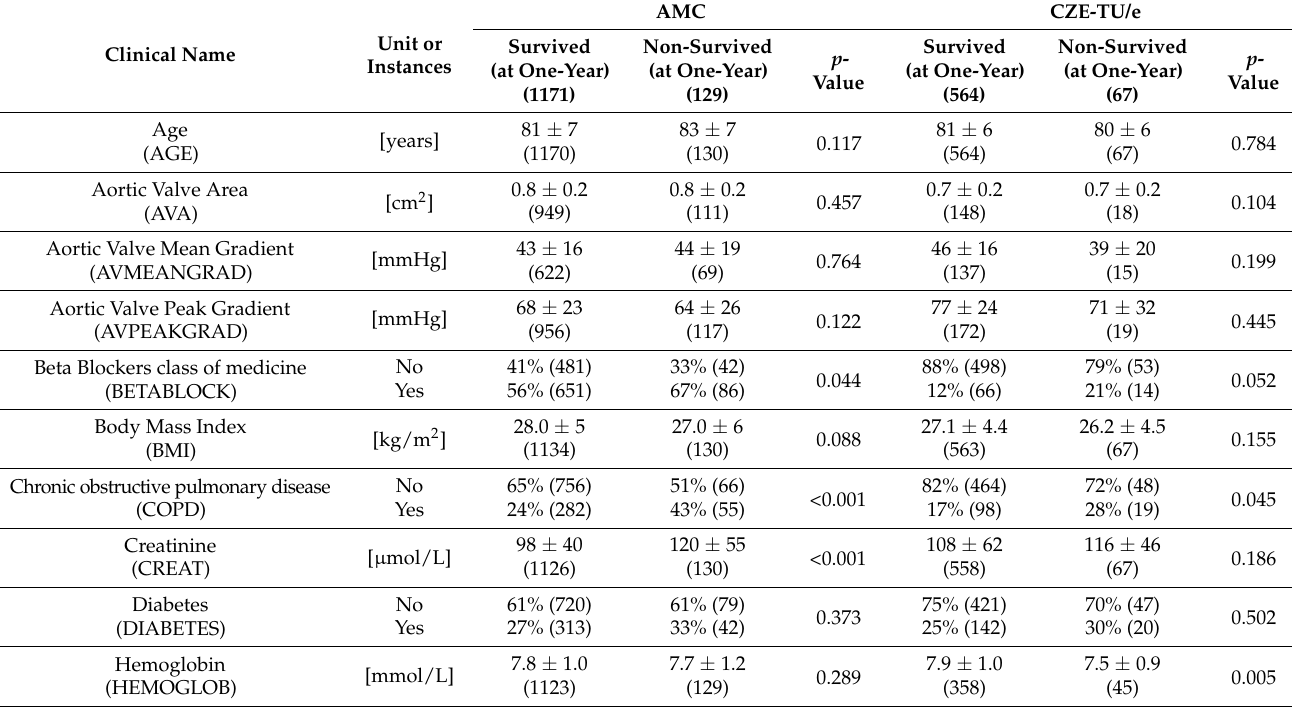
Table A3. Summarized patient characteristics from Amsterdam UMC (AMC) and Catharina hospital of Eindhoven